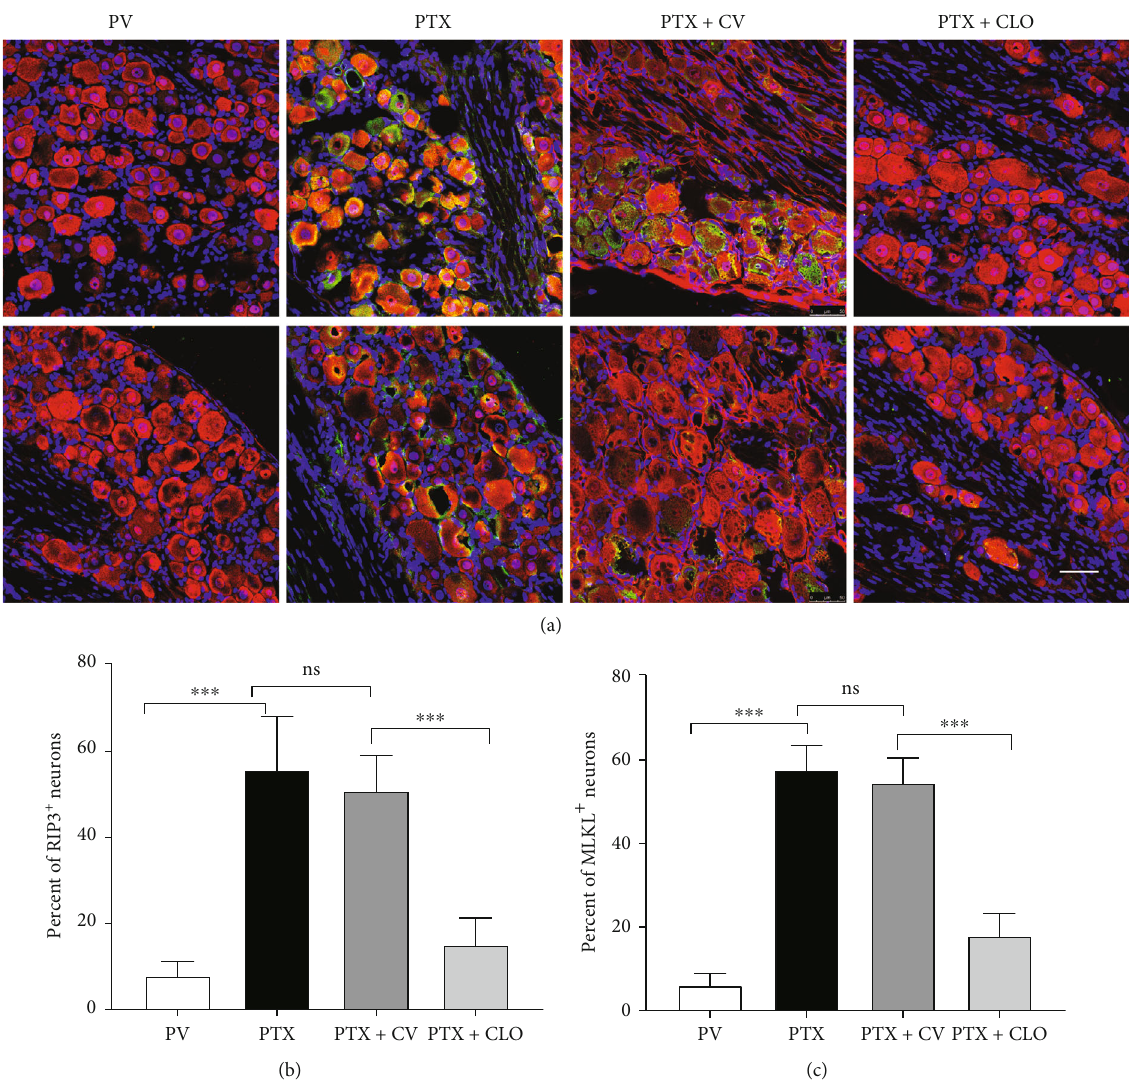
Figure 3: Expression of necroptosis-related proteins in DRG neurons evaluated by immuno fl uorescence at day 14. (a) Microphotographs show double immuno fl uorescence staining of RIP3/MLKL (green) and NeuN (red), scalebar = 50 μ m . (b) The number of neurons co- localized with RIP3/MLKL. Data are expressed as the mean ± SD ( n = 6 in each group). The results were analyzed using one-way ANOVA followed by the LSD post hoc test. Asterisks indicate signi fi cant di ff erence between two groups at ∗∗∗ P < 0 : 001 ; ns: no signi fi cant di ff erence. Abbreviations: RIP3, receptor-interacting protein kinase 3; MLKL, mixed-lineage kinase domain-like protein; PTX, paclitaxel; CLO, clodronate disodium